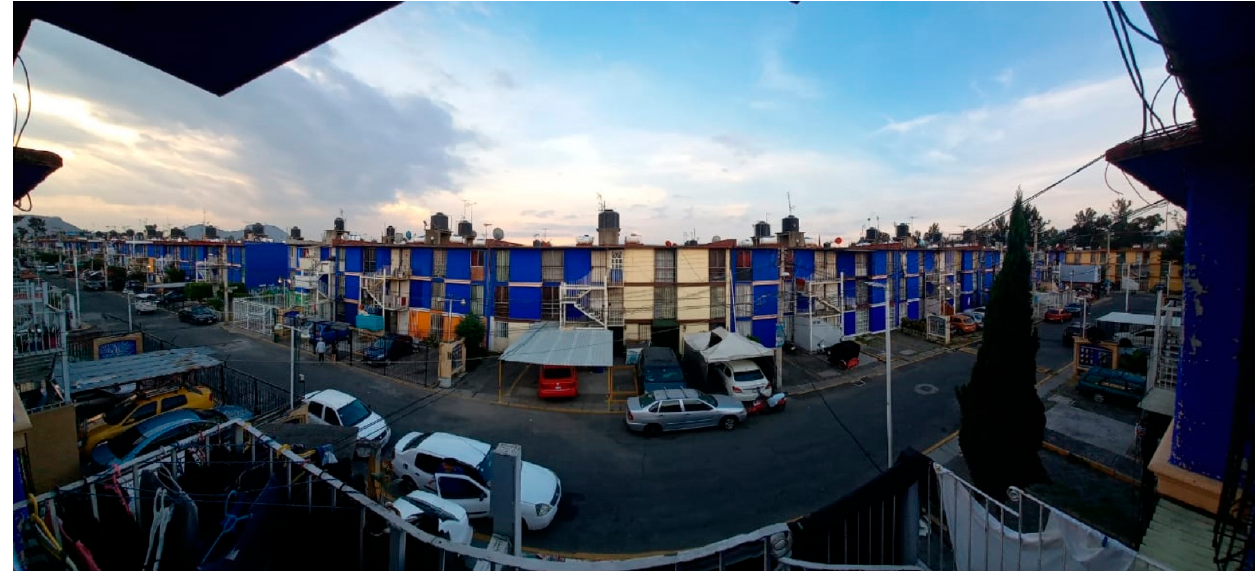
Figure 10. Apartment complex where Participant 6